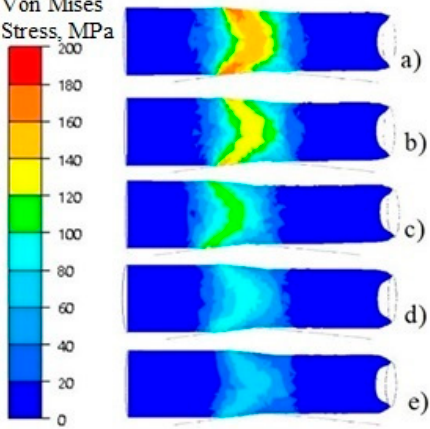
Figure 7. Von von Mises stress distributions on the longitudinal sections of deformed bars at a temperature of, respectively: a ) 150 °C; b ) 200 °C; c ) 250 °C; d ) 300 °C; and e ) 350 °C.